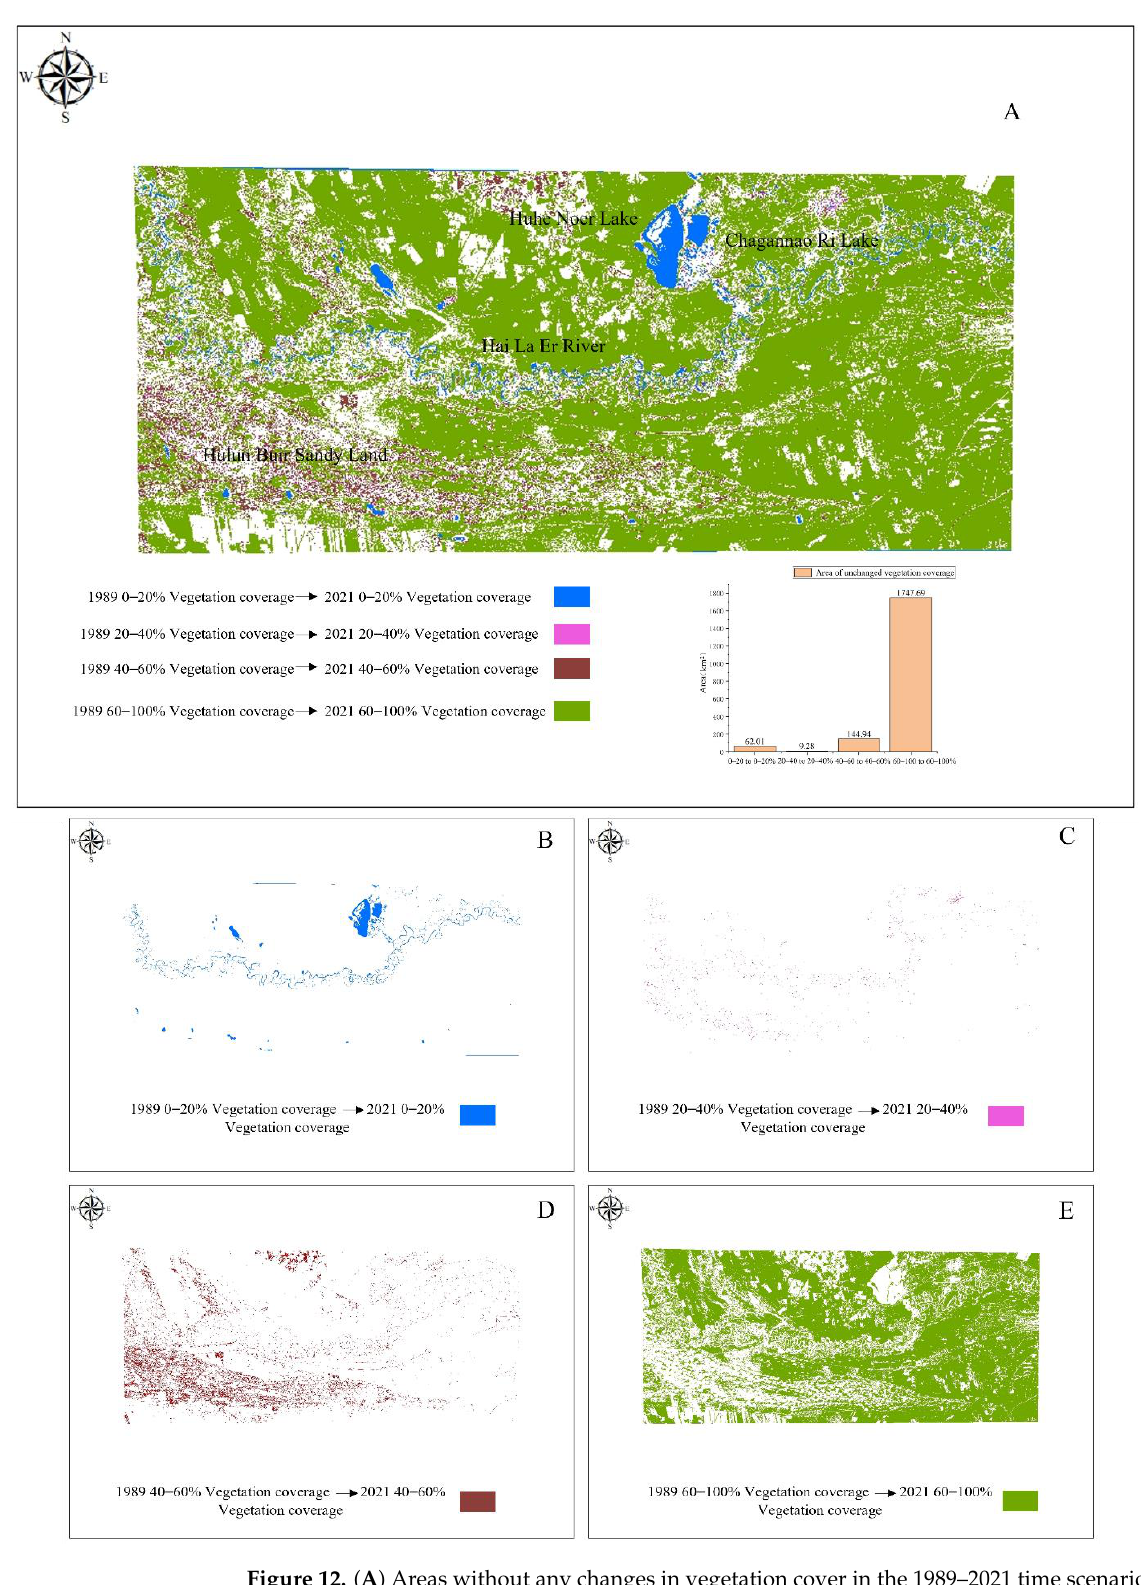
Figure 12. Areas without any changes in vegetation cover in the 1989 – 2021 time scenario ( A ): the Figure 12. ( A ) Areas without any changes in vegetation cover in the 1989–2021 time scenario; ( B ): the area of 1989 0 – 20% vegetation coverage unchange to 2021 0 – 20% vegetation coverage; ( B ): the area area of 1989 0–20% vegetation coverage unchange to 2021 0–20% vegetation coverage; ( C ): the area of 1989 20 – 40% vegetation coverage unchange to 2021 20 – 40% vegetation coverage; ( C ): the area of of 1989 20–40% vegetation coverage unchange to 2021 20–40% vegetation coverage; ( D ): the area of 1989 40–60% vegetation coverage unchange to 2021 40–60% vegetation coverage; ( E ): the area of 1989 1989 40 – 60% vegetation coverage unchange to 2021 40 – 60% vegetation coverage; ( D ): the area of 60–100% vegetation coverage unchange to 2021 60–100% vegetation 1989 60 – 100% vegetation coverage unchange to 202160 – 100% vegetation coverage ( E ).